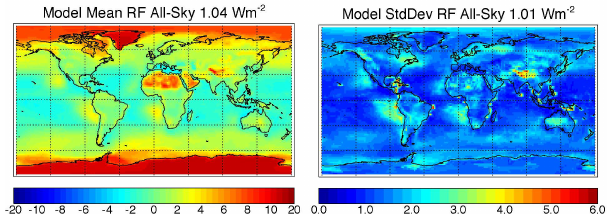
Fig. 9. Annual mean short-wave all-sky top-of-atmosphere radia- tive forcing between experiments with AOD=0.2 and AOD=0.0 distributed over the lowest two kilometers, holding SSA=0.8 and ANG=1.0 constant